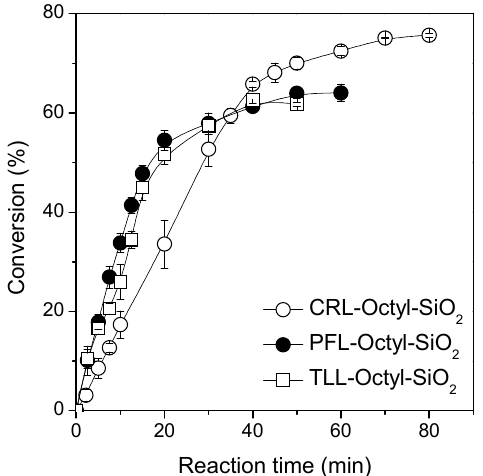
Figure 1. Effect of lipase source on the ester synthesis course. The reactions were performed at 40 °C, 240 rpm, stoichiometric acid:alcohol molar ratio containing 0.2 M of palmitic acid in heptane medium and biocatalyst concentration of 300 units of hydrolytic activity (U).